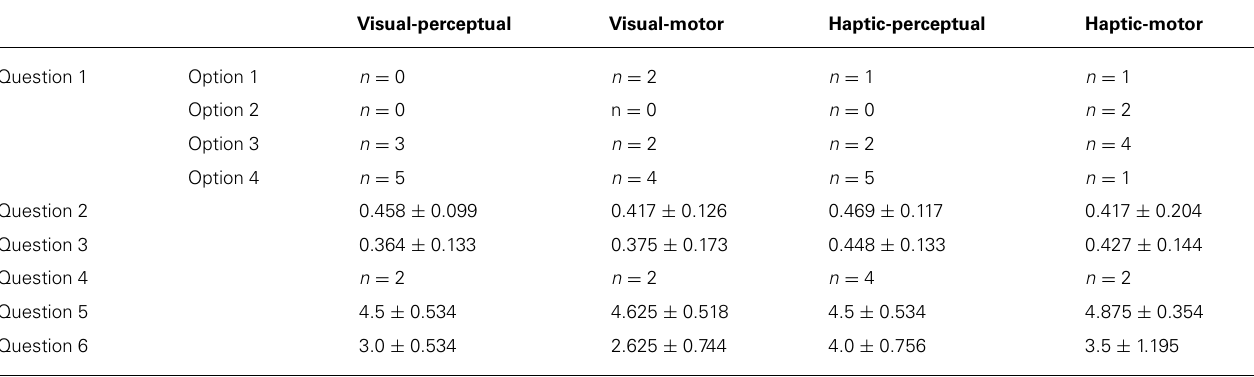
Table 1 |A summary of awareness survey